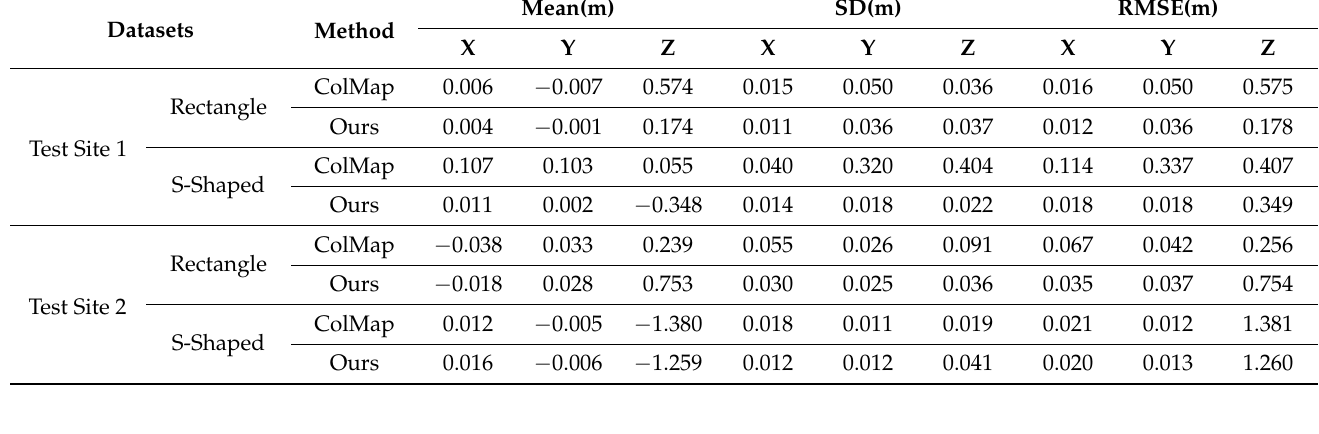
Table 4. Statistical results of self-calibration for different calibration methods.